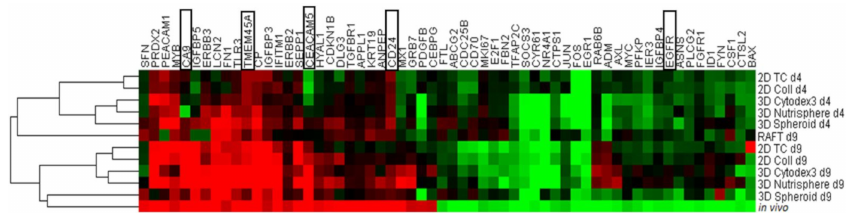
Figure 5. Long-term (day 9, d9) maintenance of 3D cultures (3D Spheroid, 3D Nutrisphere, 3D Cytodex3) mimic the in vivo situation better. The highlighted genes (black squares) were selected for subsequent analysis by single cell mass cytometry. Cluster analysis (hierarchical) was performed by Gene Cluster 3.0 software from expression data ( ∆∆ Ct, log2 values) of presented